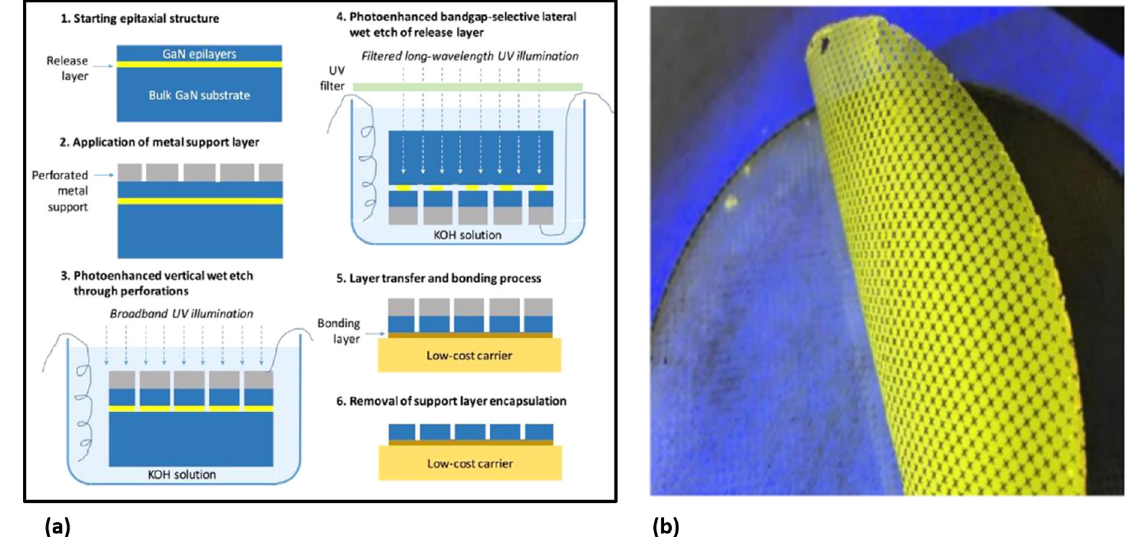
Figure 4. ( a ) The detailed process flow of ELO based on photoelectrochemical (PEC) etching, and ( b ) full 4-inch GaN layer released by PEC etching. Adapted with permission from [61]. Copyright John Wiley and Sons,